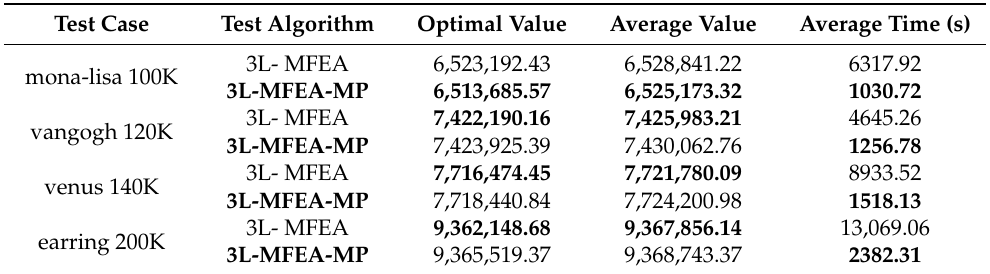
Table 3. Simulation results of multi-process algorithm and single process algorithm on four large-scale TSP data sets.